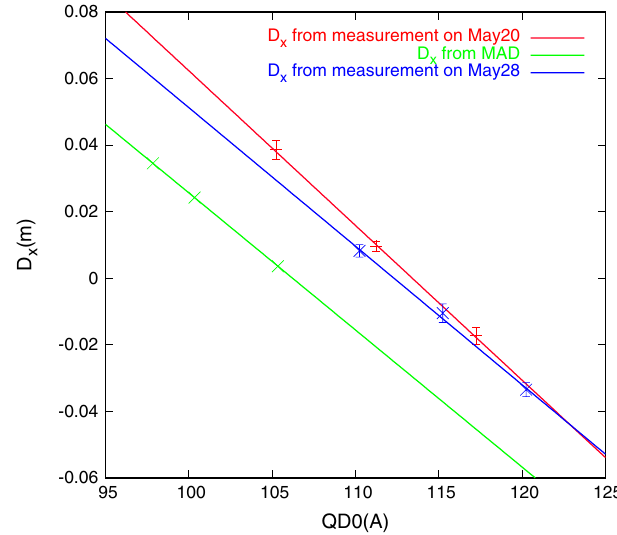
FIG. 3. Horizontal dispersion measurements at post-IP wire scanner and prediction from MAD .